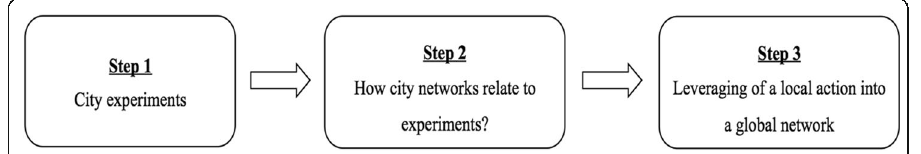
Fig. 1 An analytical model for understanding experimentation within city